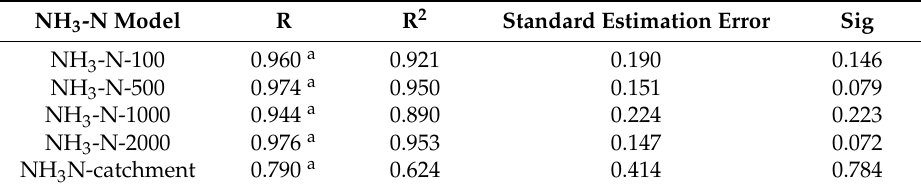
Table 12. The linear model general situation of NH 3 -N.